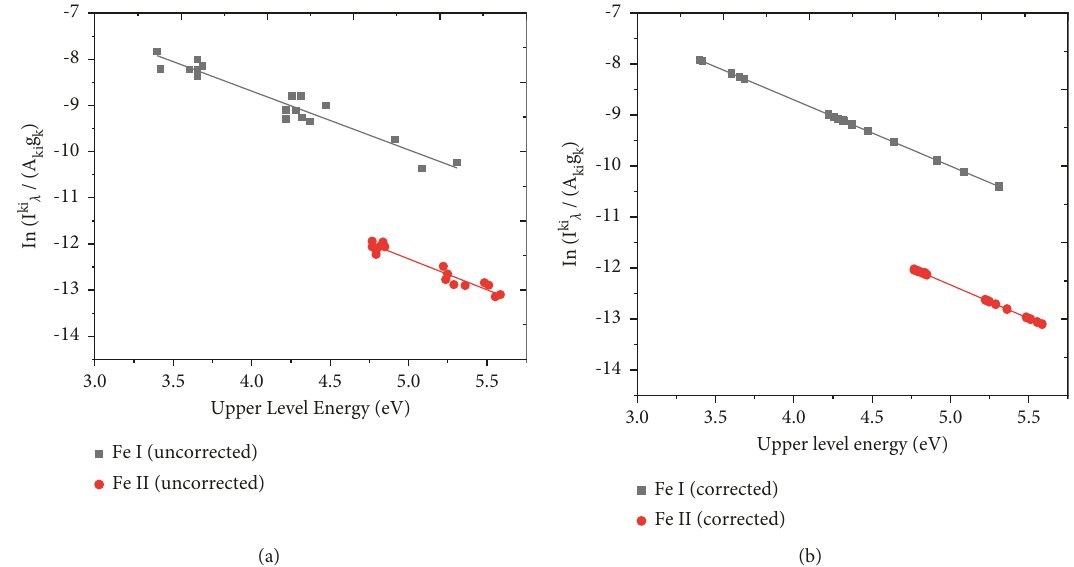
Figure 4: (a) Boltzmann plots built without self-absorption corrections of Fe I and II emission lines; the red lines linearly fit the ex- perimental data points. (b) Boltzmann plots built with self-absorption correction on the Fe I and II emission lines; the red lines linearly fit the experimental data